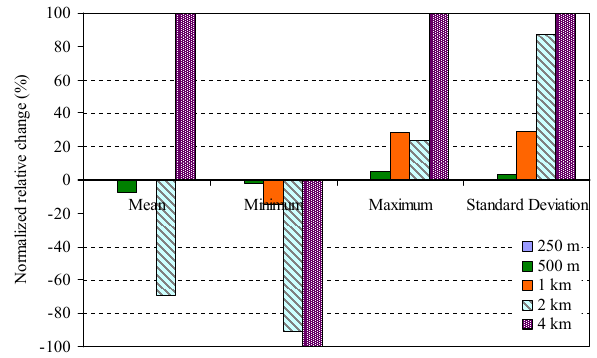
Fig. 5. Normalized relative change of the mean, minimum, max- imum, and standard deviation of carbon sequestration rates as the spatial resolution of land cover information changed from 250m, to 500m, 1km, 2km, and